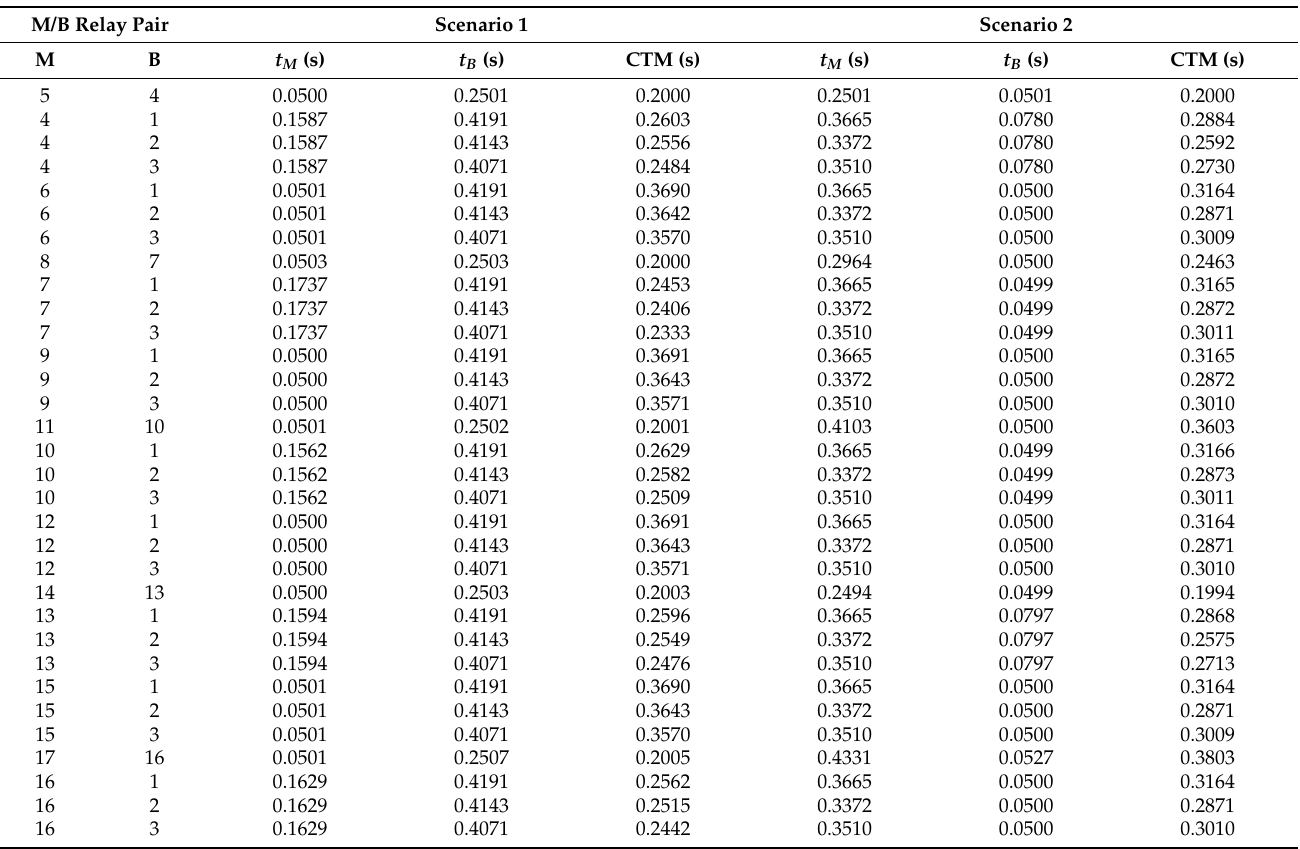
Table 8. Operating times of M/B relay pairs with their associated CTM values of the Agiba Network using Test Model